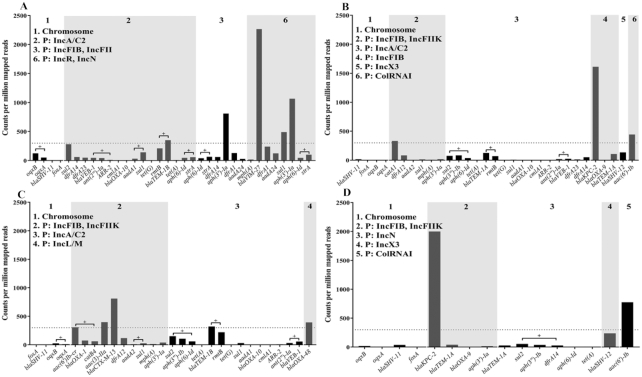
Expression of resistance genes via direct RNA sequencing when aligned to completed genomes. (A) 1_GR_13, (B) 2_GR_12, (C) 16_GR_13, and (D) 20_GR_12. The x-axis depicts the resistance genes, which are grouped on the basis of the location in the genome, where P indicates a plasmid followed by replicon identity. Albacore 2.2.7 base-called pass and fail reads were used for analysis. Values indicate counts per million mapped reads (cpm) (after removal of reads mapping to rRNA), and dotted line is set to 300 cpm. Genes are represented in order of appearance on contig, and plus sign indicates the co-expression of genes.